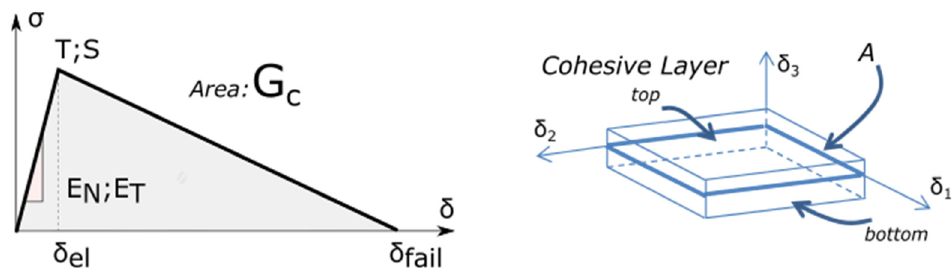
Figure 7. Cohesive constitutive law-bilinear shape; schematic cohesive element representation with the definition of constitutive displacement relative to the top and bottom surface of adjacent shell layers. Table 6. MAT138 material parameters for the interlaminar region.